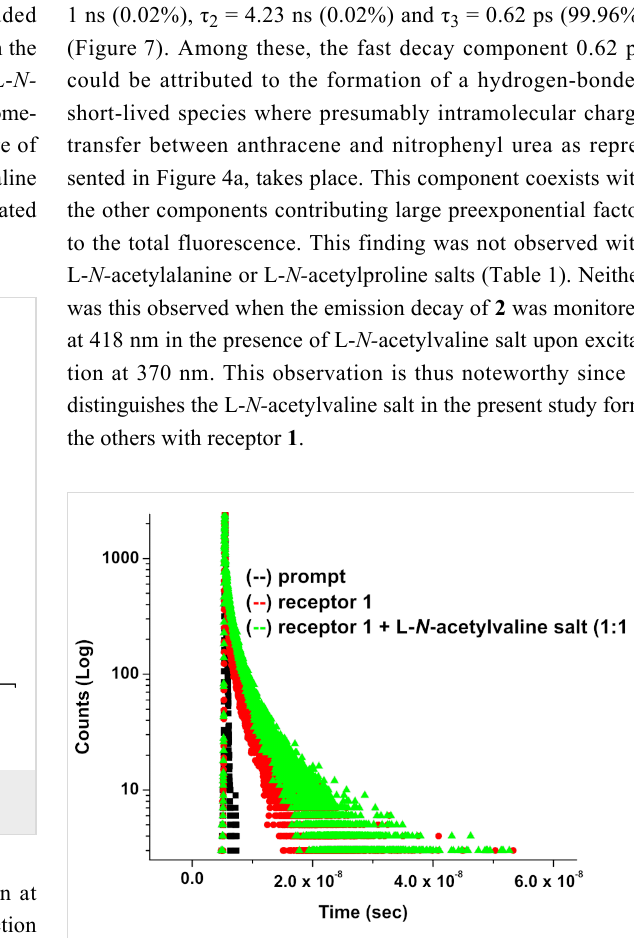
Figure 7: Fluorescence decays (at λ max = 420 nm) of receptor 1 upon the addition of 1 equiv of L- N -acetylvaline salt ([H] = 4.71 × 10 − 5 M, [G] = 9.42 × 10 − 4 M) in CH 3